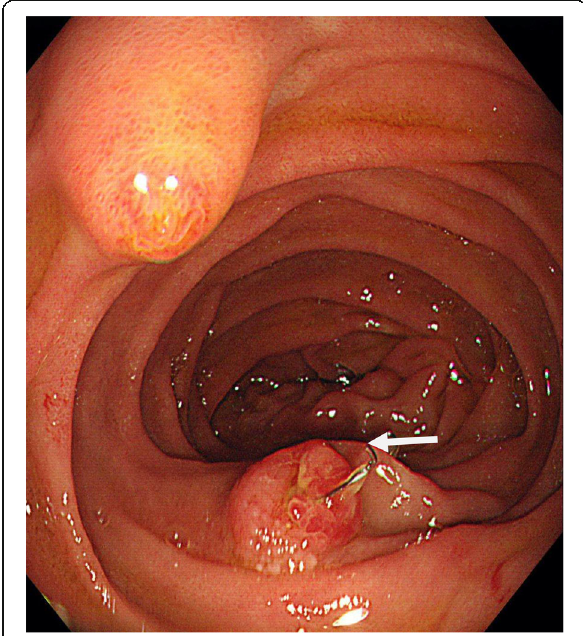
Fig. 1 Esophagogastroduodenoscopy (EGD) showed that IVC filter strut penetrated the third portion of the duodenum (arrow)